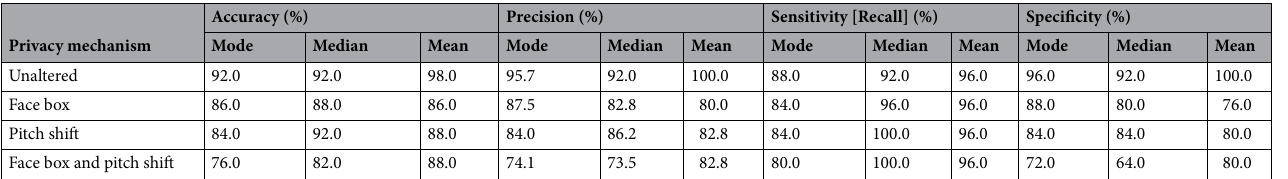
Table 3. Performance of the LR5 classifier on aggregated crowd features across privacy-preserving mechanisms when using the mode, median, and mean aggregation methods, respectively. Sensitivity of the classifier is retained even with the most stringent privacy-preserving mechanisms. A probability threshold of 0.5 was used to distinguish the ASD and neurotypical